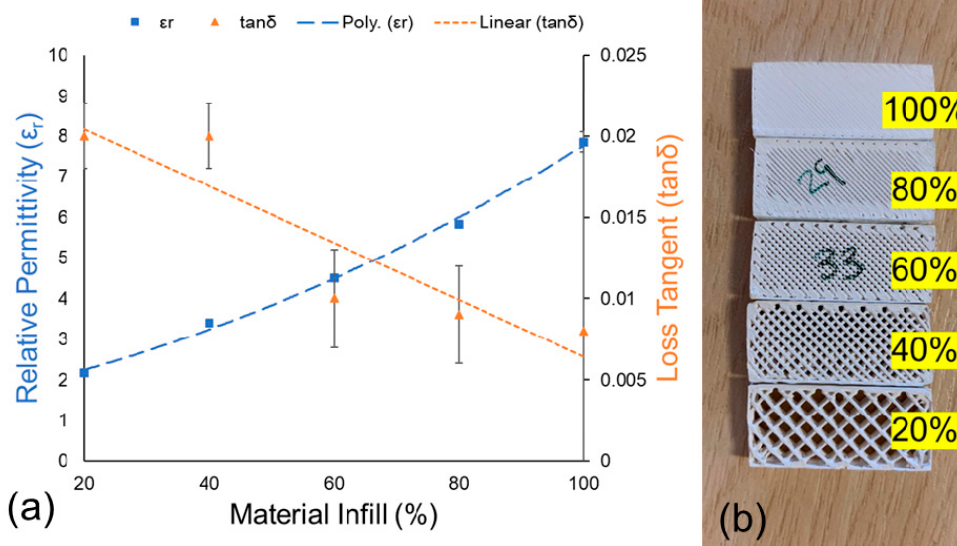
Figure 7. ( a ) Material Infill (%) vs. relative permittivity ( ε r ) and loss tangent ( tan δ ), ( b ) Examples of built test samples with variable material infill.